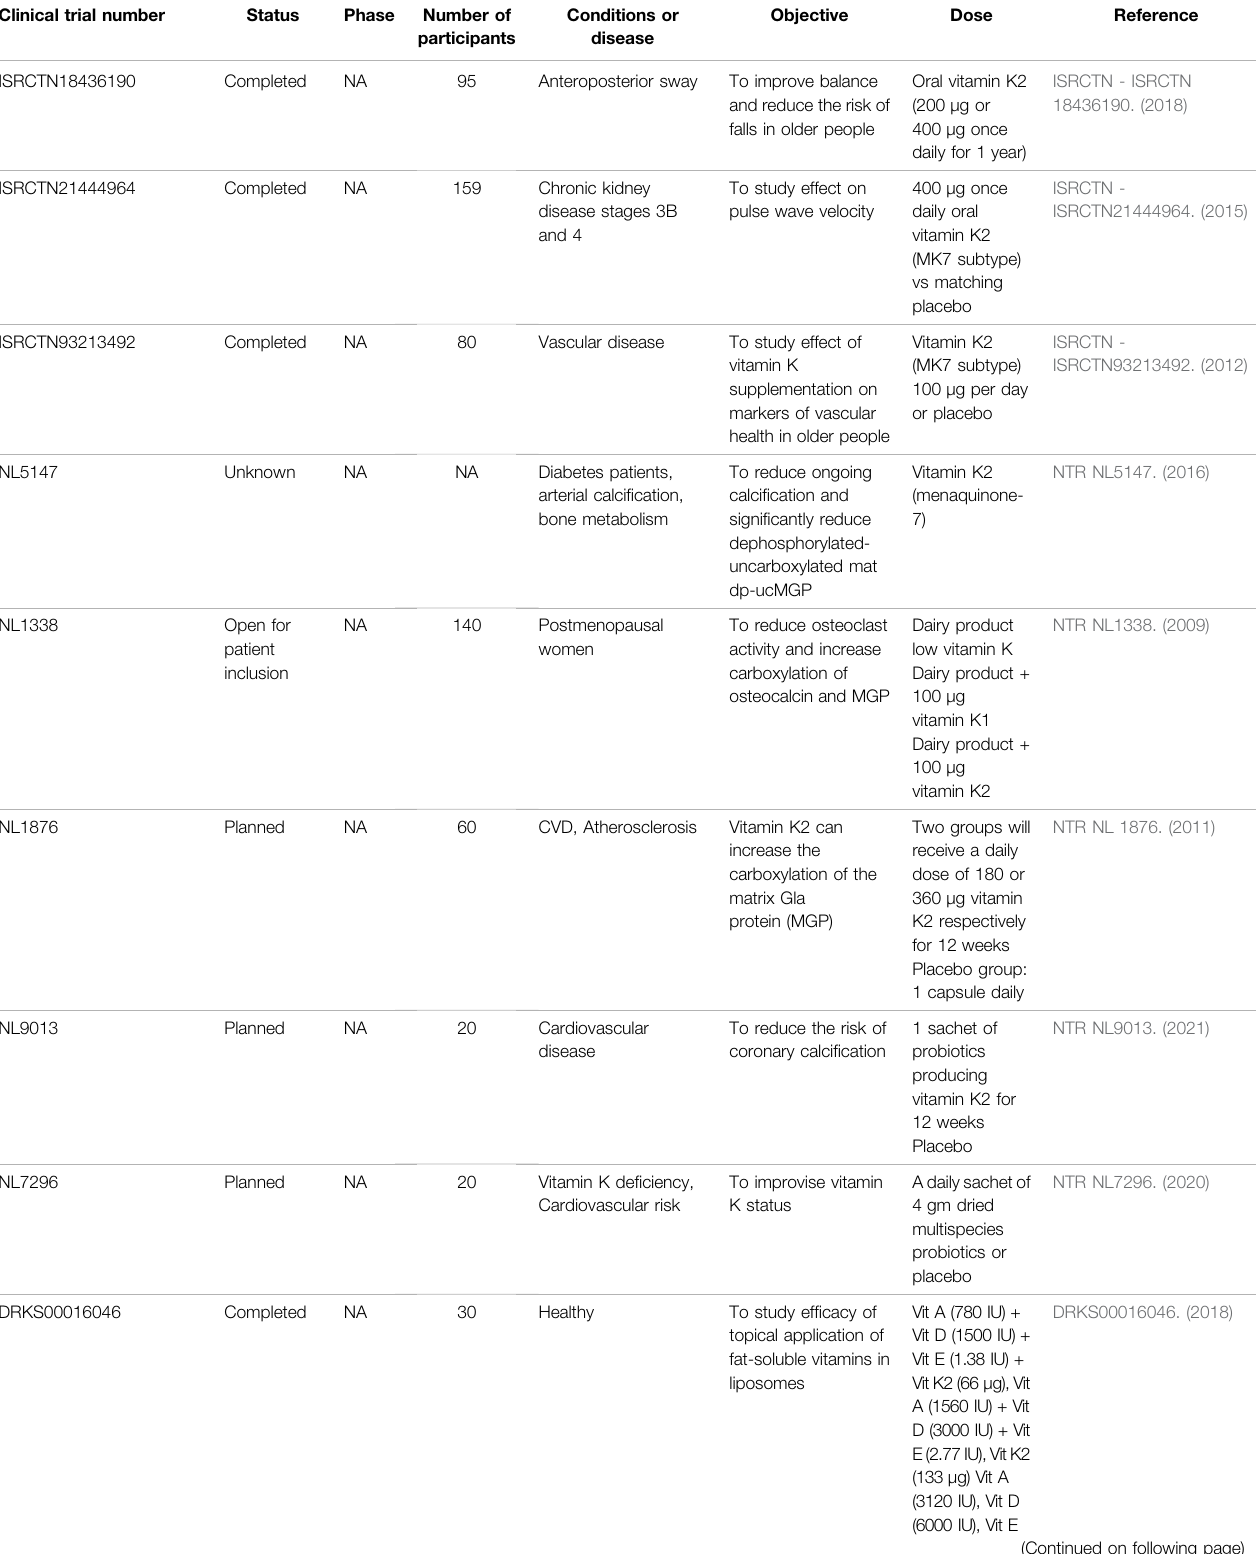
TABLE 4 | Other global clinical trials on vitamin